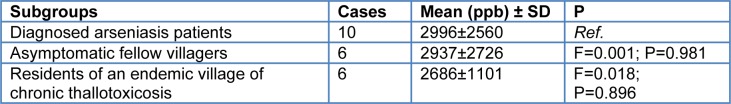
Comparison of As75 in hair samples of residents of an arseniasis-endemic village and of a thallotoxicosis-endemic village